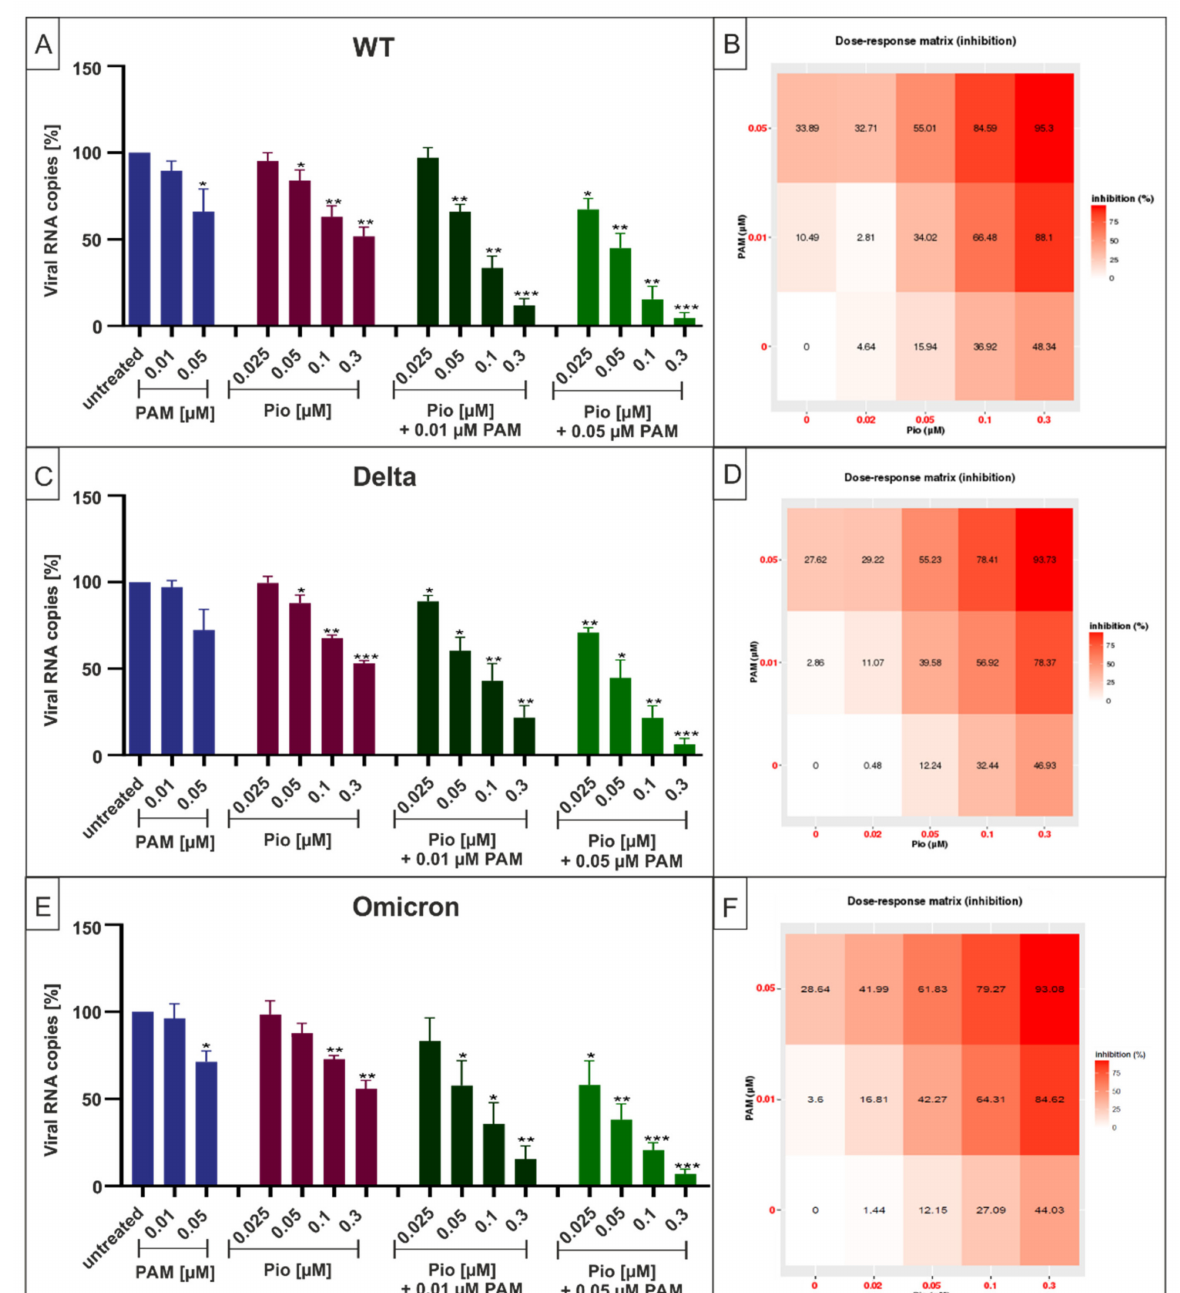
Figure 7. Antiviral activity of the combinatory treatment of PAM with Pio following infection with SARS-CoV-2 Wuhan type, Delta, and Omicron. ( A , C , E ) Calu-3 cells were infected with SARS-CoV- 2 PR-1 ( A ), SARS-CoV-2 Delta ( C ), and SARS-CoV-2 OM ( E ) at a MOI of 2 × 10 − 2 . One hour after infection and removal of input virus, cells were treated with indicated concentrations of PAM (blue), Pio (red), or the combinatory treatment of PAM and Pio (green). Cell culture supernatants were harvested at 3 dpi. The virions were purified and analyzed by qRT-PCR. Data represent means of three independent experiments ± standard deviation (* p ≤ 0.05, ** p < 0.005 and *** p < 0.001) using a One sample t test, where each value is compared to the untreated control. ( B , D , F ) percent of the inhibition of viral replication following combined treatment with PAM and Pio and infection with SARS-CoV-2 PR-1 ( B ), SARS-CoV-2 Delta ( D ), and SARS-CoV-2 OM ( F ). The tables were created using the open-source and free web application SynergyFinder